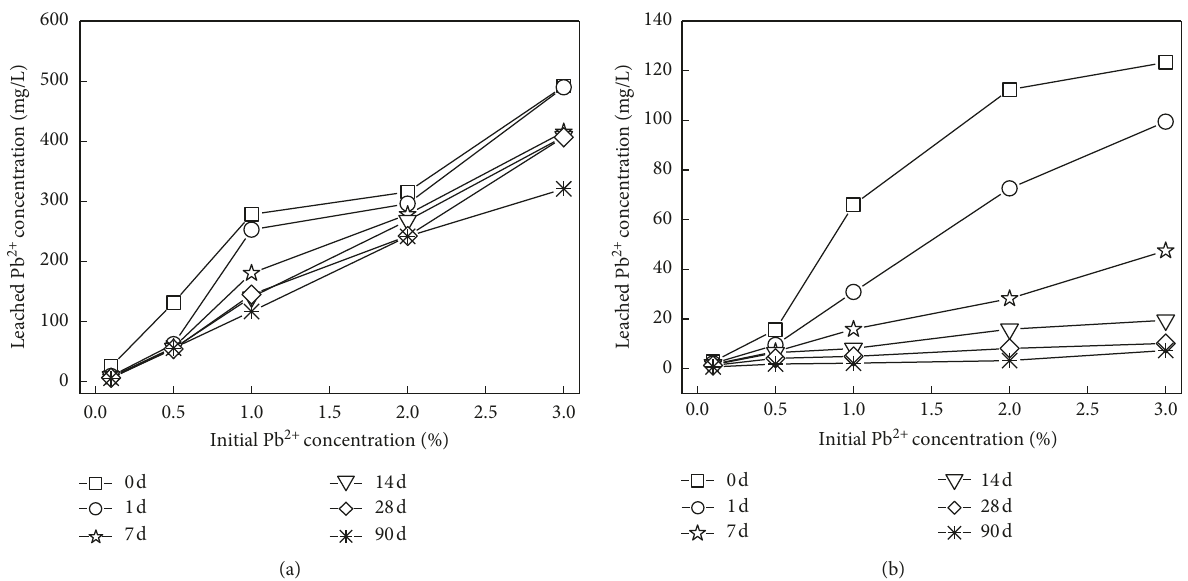
Figure 8: Evolutions of the leached Pb 2+ concentration with the initial Pb 2+ concentration of the specimen. Alkaline residue contents of (a) 10% and (b)